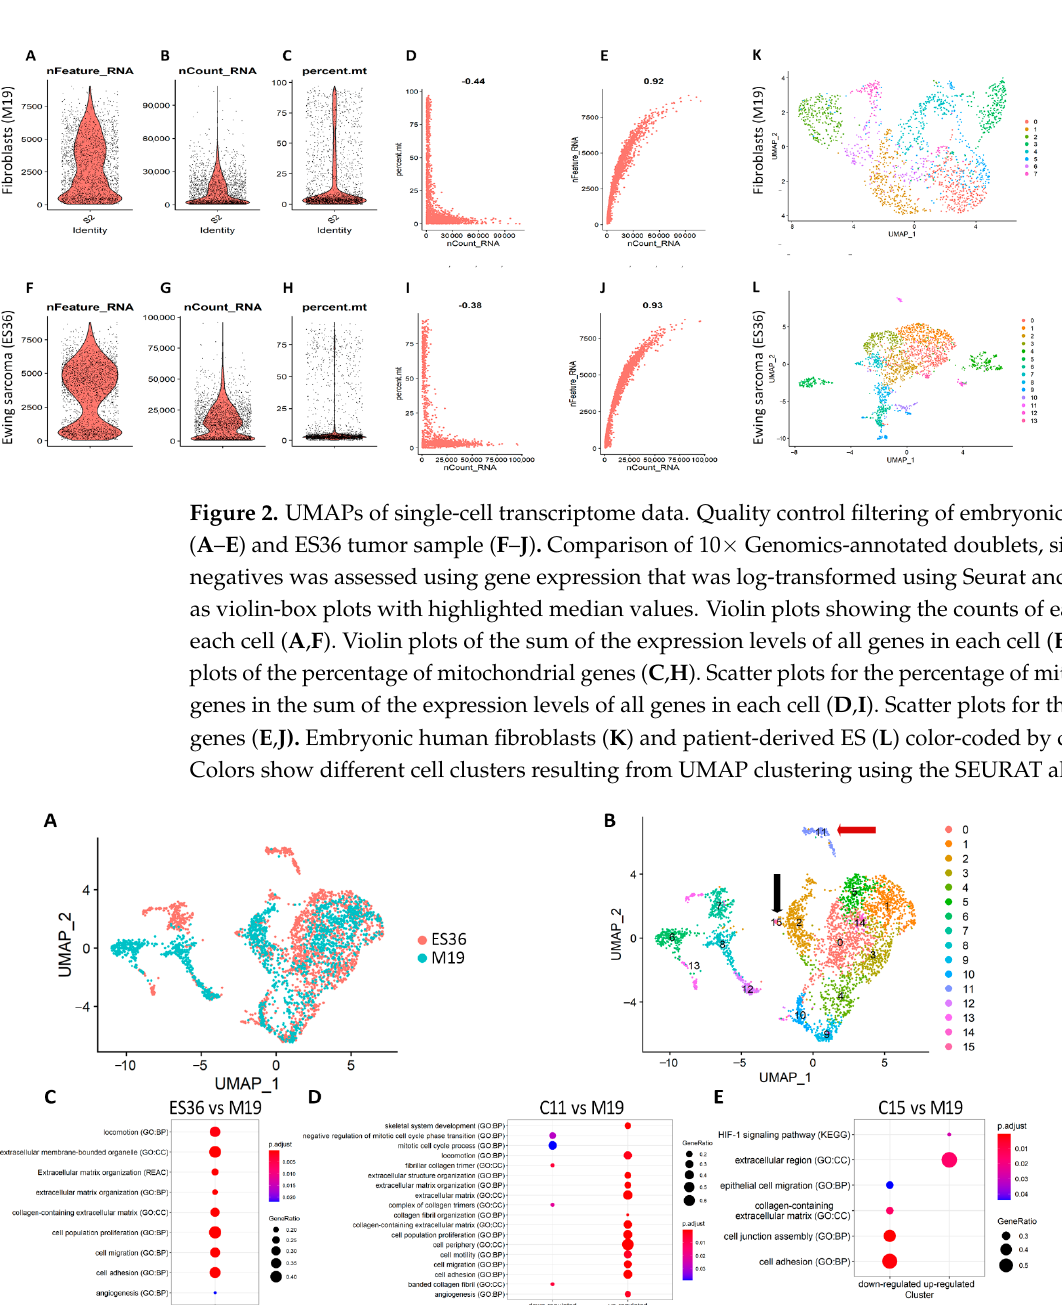
Figure 3. A single-cell ecosystem of embryonic fibroblasts and ES 36 cells. ( A ) Datasets for 10× Genomics analysis were derived from M19 fibroblasts and short-lived patient-derived ES culture (ES36). The 10× Genomics plots identify groups of cells with similar expression patterns. The average of 5000 cultured M19 cells and ES36 cells were green or red color-coded. ( B ) Distribution of single-cell population for each type of cell in the UMAP plot (first two dimensions) in accordance with the clusters made using the Seurat algorithm. Arrows point to the unique clusters that present in ES-patient-derived ES36 tumor culture; GO term analysis that summarizes the biological function and cellular component was performed for DEGs in ES36 tumor cells cluster 11 ( n = 131 cells) ( C ) or cluster 15 ( n = 18 cells) ( D ) vs. M19 cells, and also between these ES36 clusters (11 vs. 15), respectively ( E ). The specificity of gene expression value has been normalized and visualized as a circle that corresponds with the ratio of gene expression in ES36 cells vs. M19. The size of nodes indicates the number of cells in each cluster with that ratio.